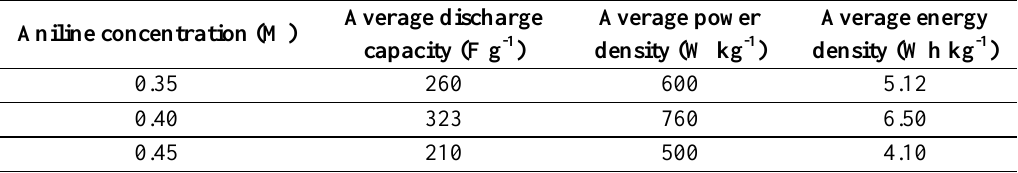
Table 1 : Comparison of discharging capacity, power density and energy density with respect to variation of the Aniline